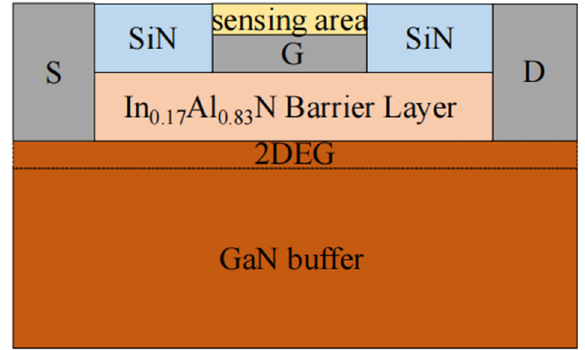
Figure 1. Schematic diagram of the InAlN/GaN HEMT.